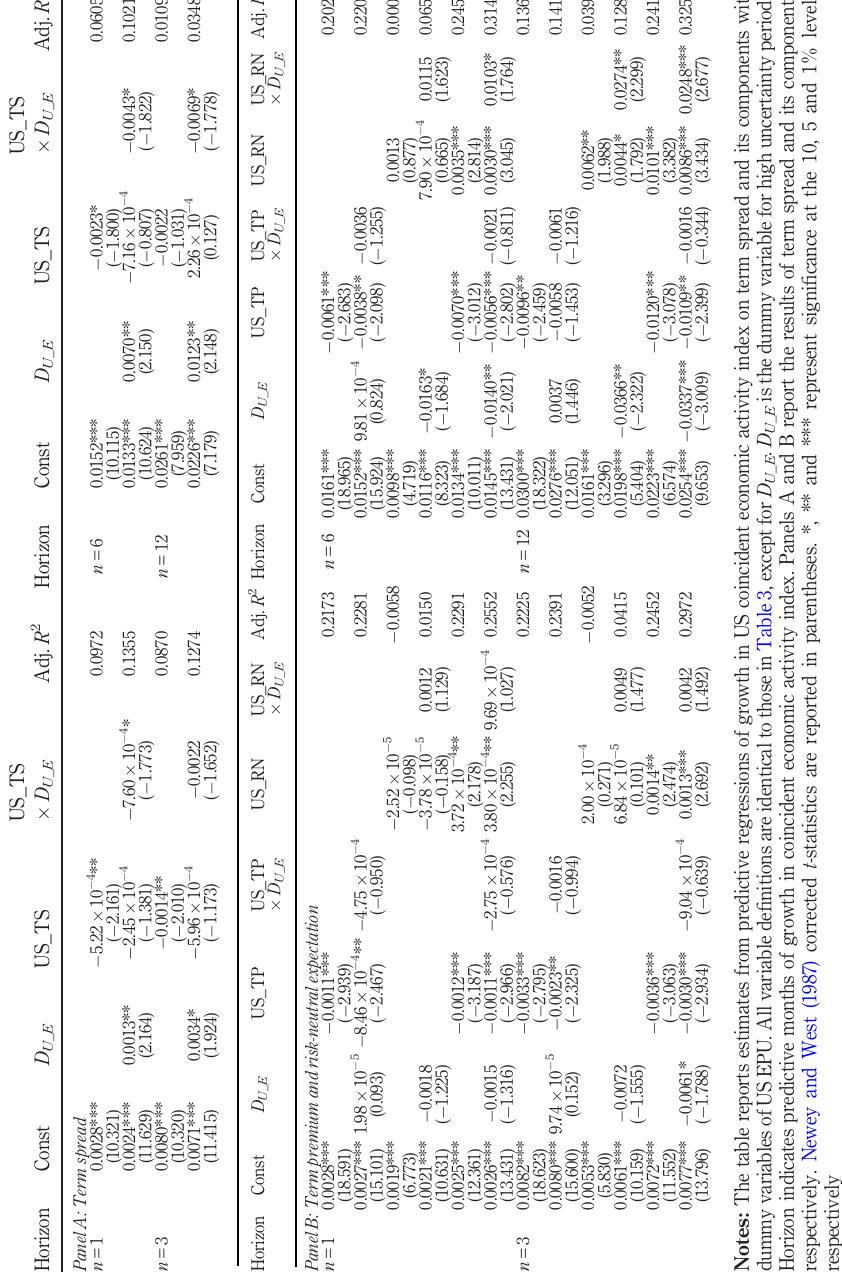
Table 9. Information of term spread and its components with uncertainty in US economy: Coincident economic activity